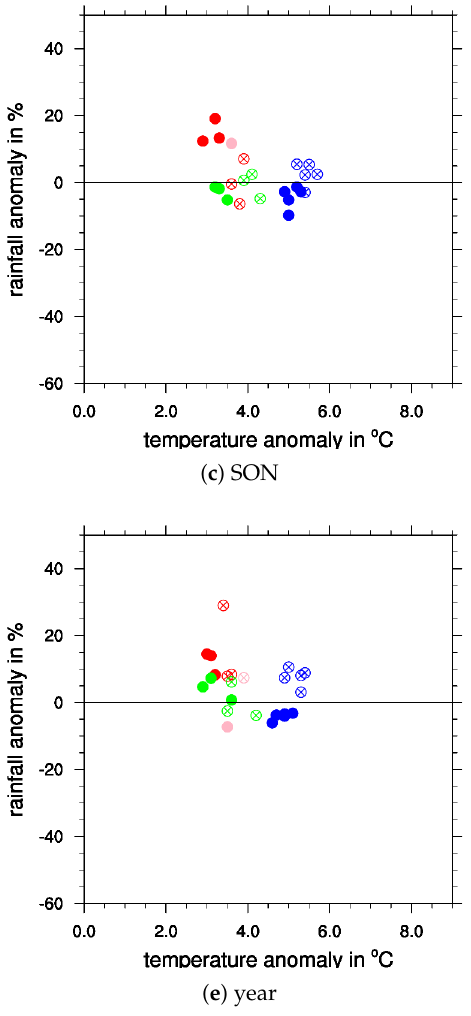
Figure 4. Comparison of the direct GCM output (crossed circles) and EPISODES downscaling results (filled circles) based on RCP8.5 (CMIP5) for Germany. The symbols show the Germany-wide mean climate change signal in annual/seasonal precipitation and temperature for 2071–2100 with respect to 1971–2000. Different colours correspond to different GCMs. (Seasons: ( a ) spring (MAM), ( b ) summer (JJA), ( c ) autumn (SON), ( d ) winter (DFJ), and ( e )